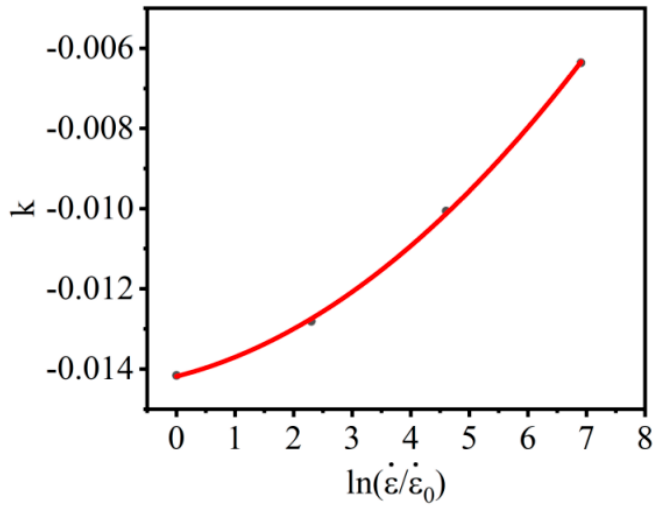
Figure 10. The correlation of k and in NM–JC.